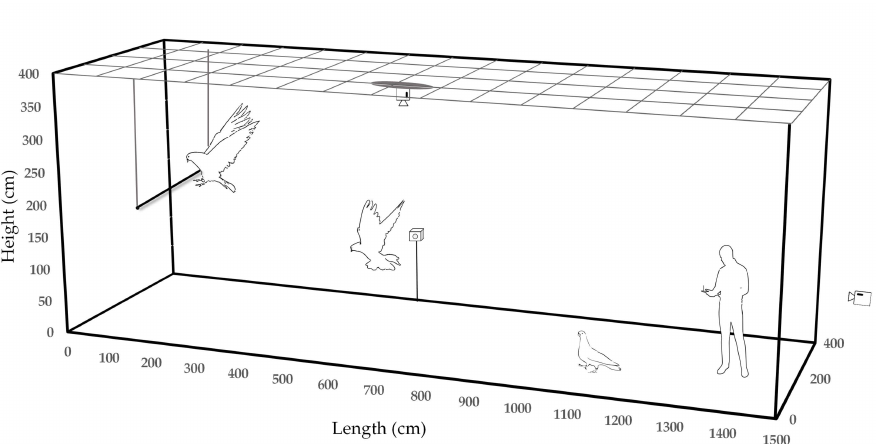
Figure 2. Diagram of 3D motion tracking. Cameras were orthogonally placed to acquire the pigeon’s flight trajectory in Cartesian